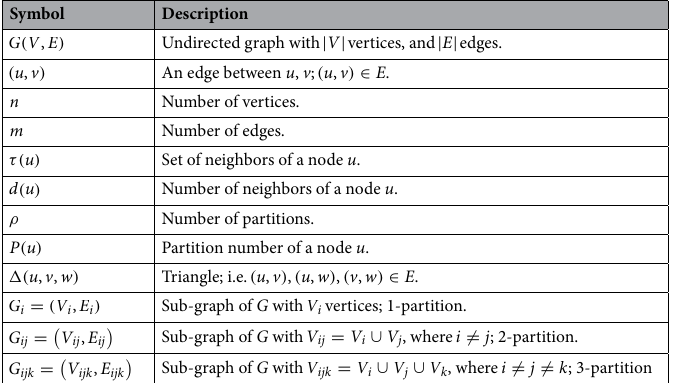
Table 1. Notations used in this